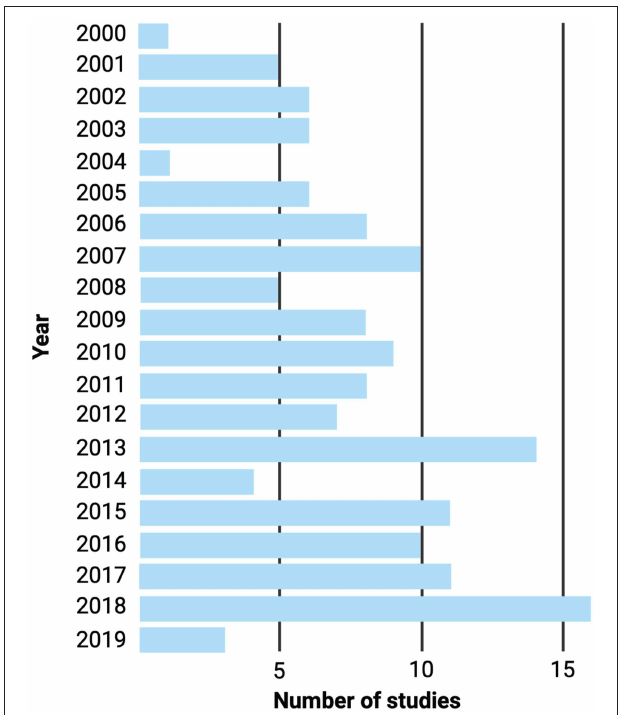
FIGURE 1 | Number of paediatric SIBO publications on PubMed from 2000 to 2019. PubMed literature search with the entry block “(children OR pediatrics) AND (small intestinal bacterial overgrowth OR small intestine bacterial overgrowth OR small bowel bacterial overgrowth)”; the search was conducted on March 26,